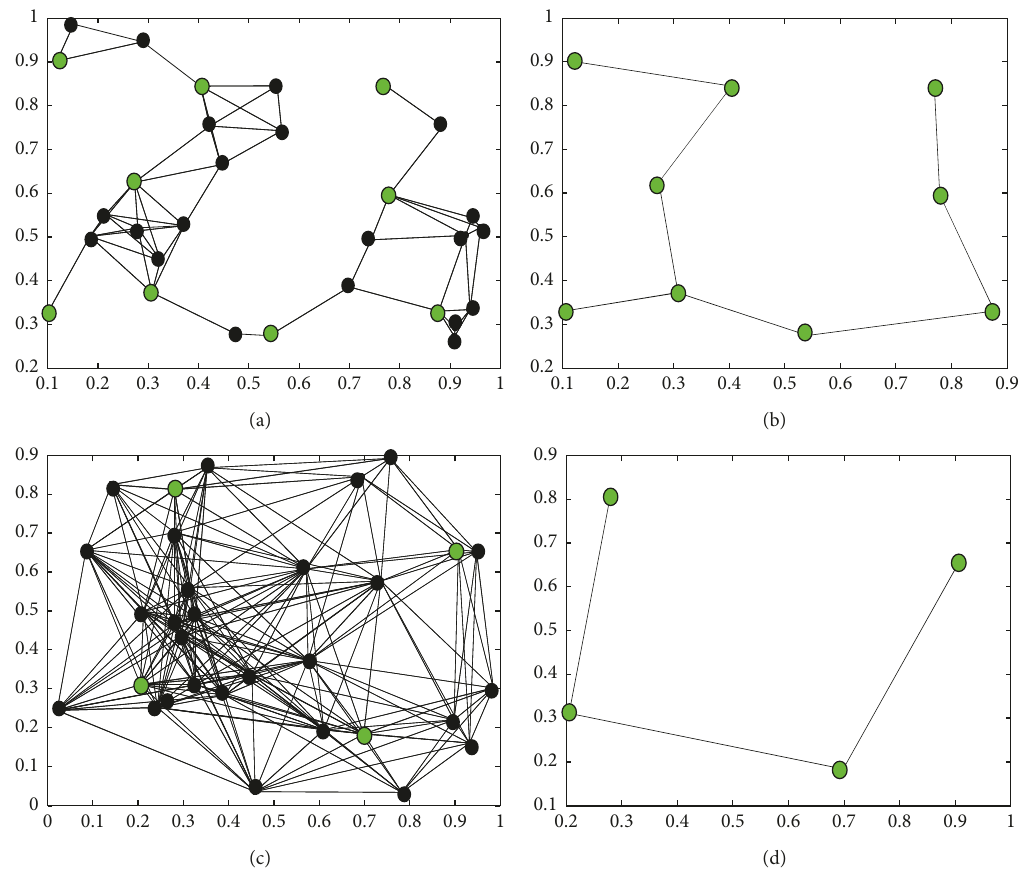
Figure 1: Input graphs and feasible solutions obtained for an instance with | V | � 30 nodes and | K | � 50 users using radial coverage values of 0.2 and 0.5 km: (a) independent set using 0.2km; (b) minimum spanning tree backbone using 0.2km; (c) independent set using 0.5km; (d) minimum spanning tree backbone using